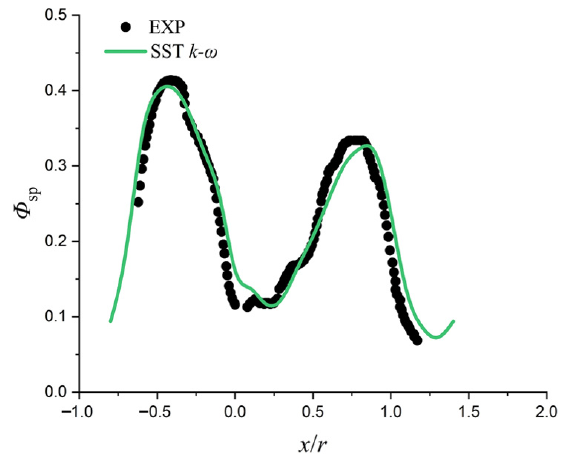
Figure 9. Comparison of span-wise averaged overall cooling effectiveness at Tu = 0.5%.